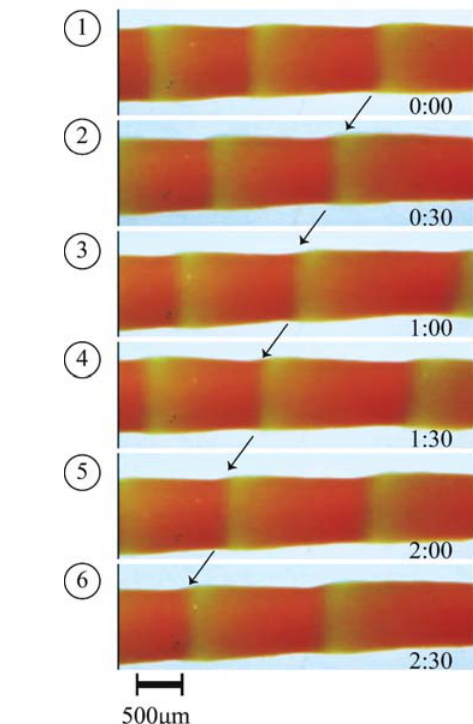
Figure 3. Time course of peristaltic motion of poly(NIPAAm-co-Ru(bpy) 32+ -co-AMPS) gel in a solution of the BZ substrates (MA, NaBrO orange colors correspond to the oxidized and reduced states of the Ru moiety in the gel, respectively (Reference